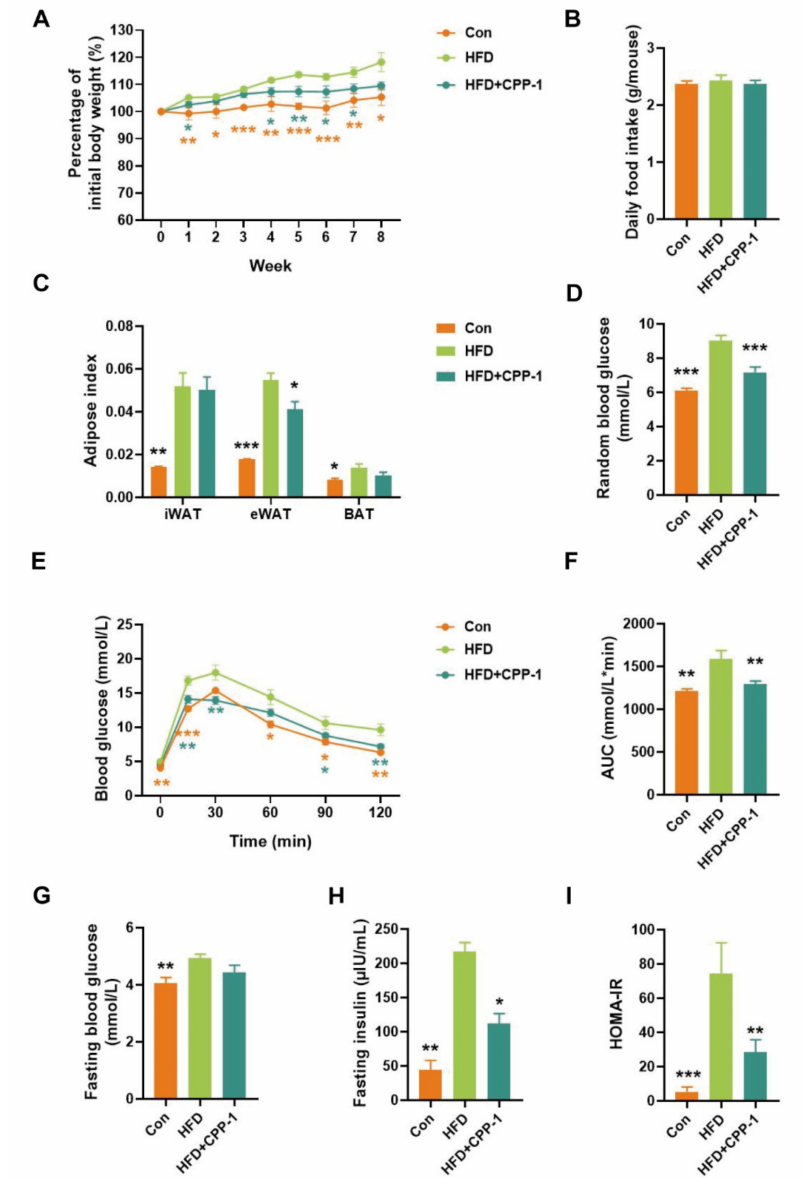
Figure 3. CPP − 1 reduced HFD-induces body weight gain and improved glucose metabolism in mice. ( A ) Percentage of initial body weight; ( B ) daily food intake; ( C ) adipose index (adipose